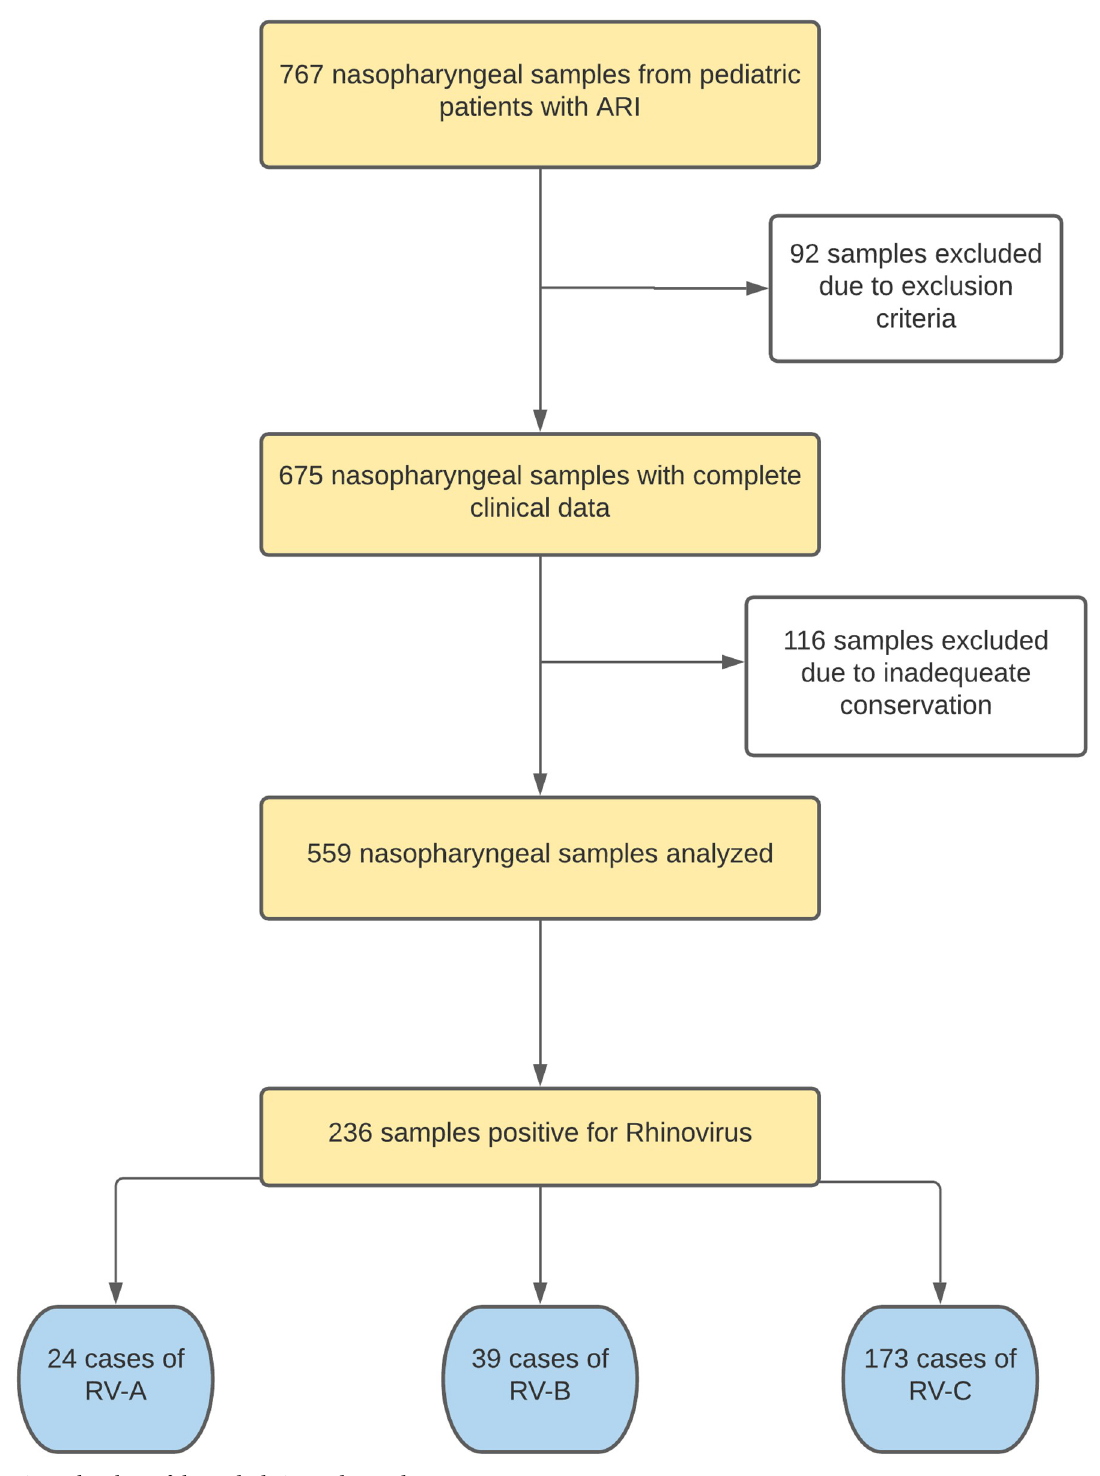
Fig 1. Flowchart of the study design and procedures.